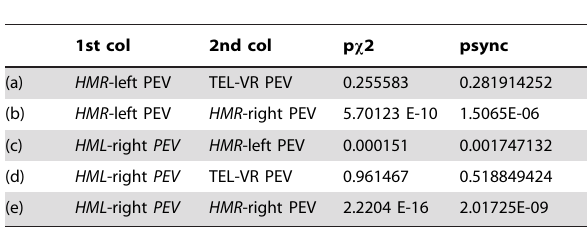
Table 5. Statistical test for